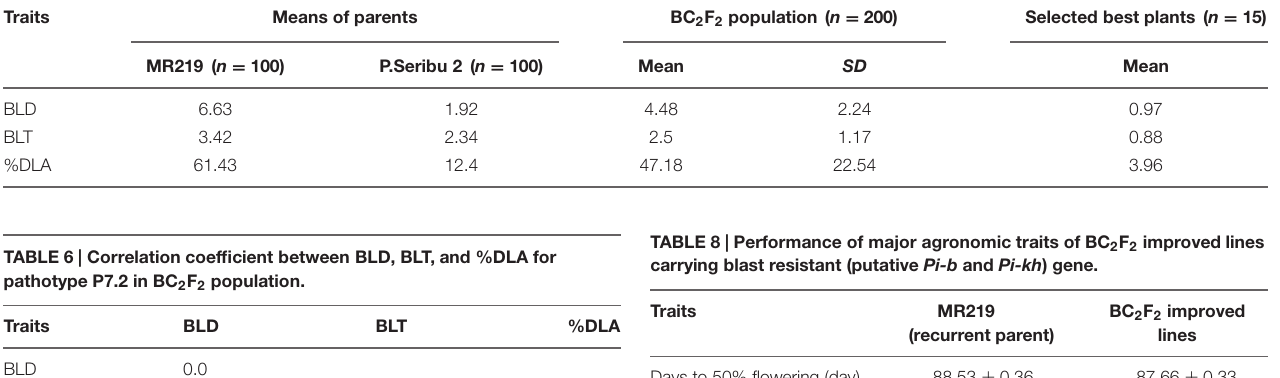
TABLE 5 | Trait variation for selected pathotype P7.2 of Magnaporthe oryzae inoculated in BC 2 F 2 population. Traits